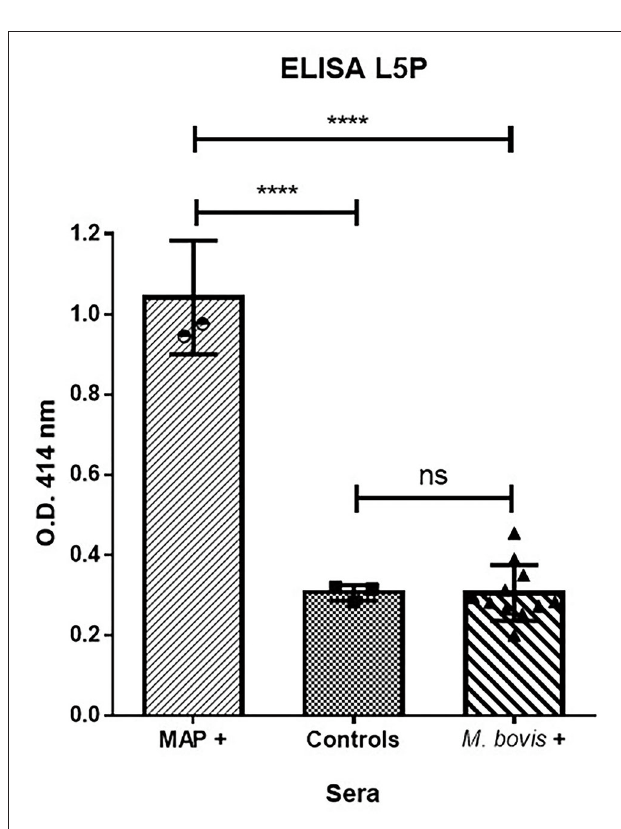
FIGURE 5 | L5P used to discriminate MAP infected cattle from M. bovis infected cattle. ELISA were performed on plates coated with L5P in ethanol. The panel of sera tested included 3 MAP positive sera of reference, 3 negative controls, and 11 M. bovis positive sera. Serum samples were tested in triplicate. The statistical differences between the groups were determined using the non-parametric Mann–Whitney test. Significantly different when p < 0.05. **** p < 0.0001. Not significantly different